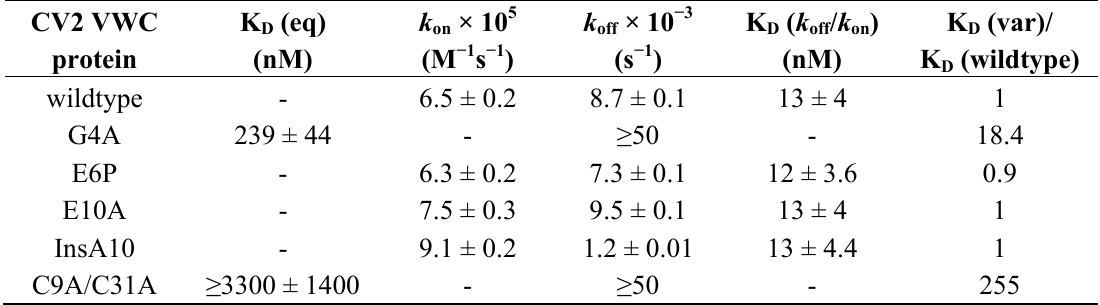
Table 2. In vitro interaction data for the binding of CV2 VWC1 and mutants thereof to